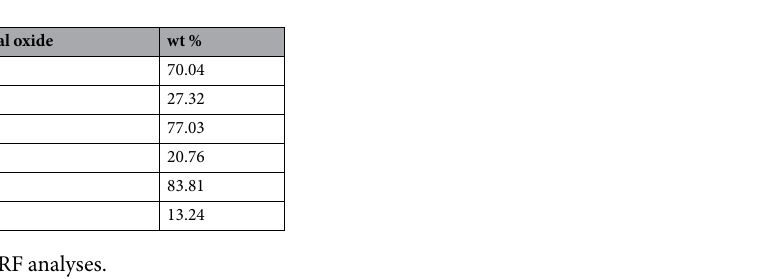
Table 1. Summary of XRF